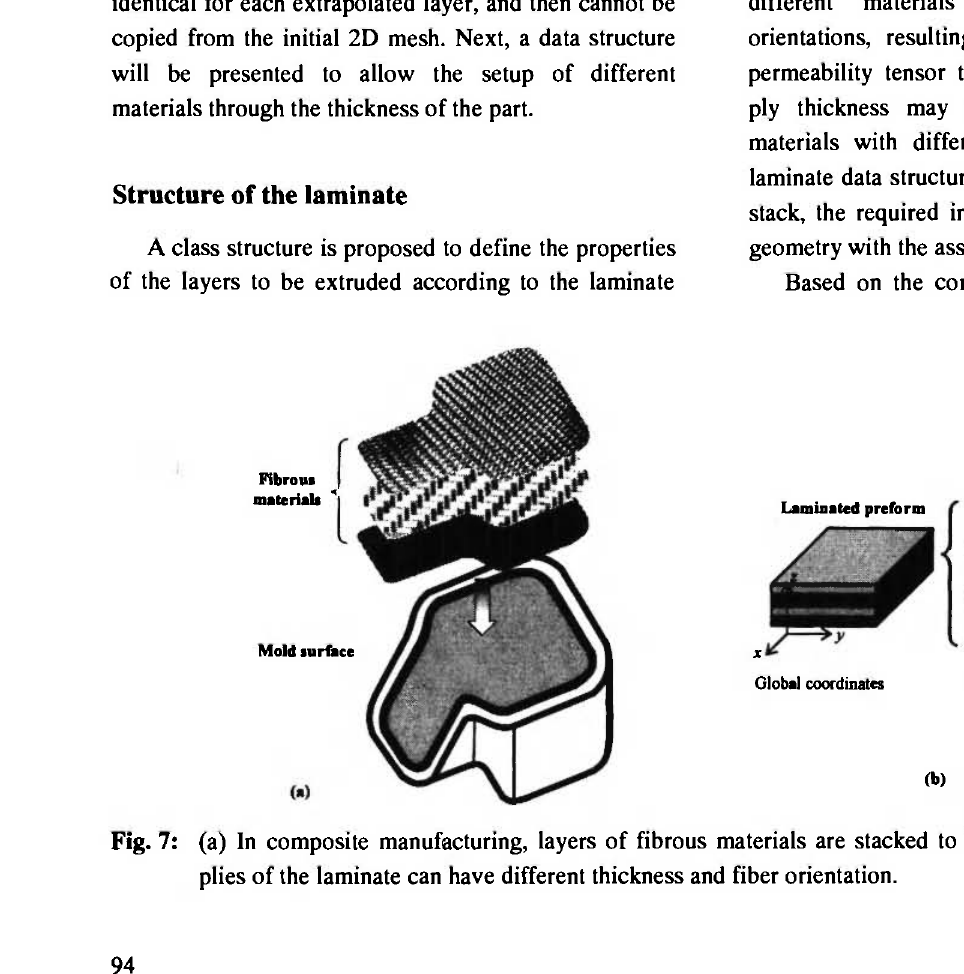
Fig. 7: (a) In composite manufacturing, layers of fibrous materials are stacked to form a compact preform, (b) The plies of the laminate can have different thickness and fiber